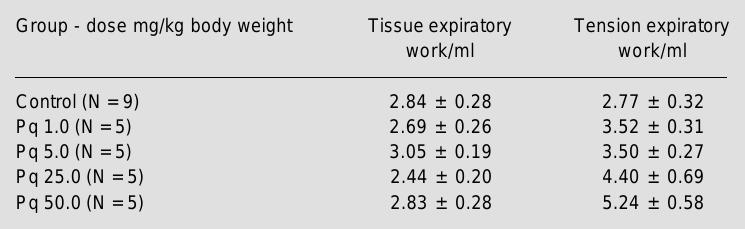
Table 2 - Expiratory work/ml attributable to tissue and surface tension for the control group and paraquat (Pq) group. Data are reported as means ± SEM.